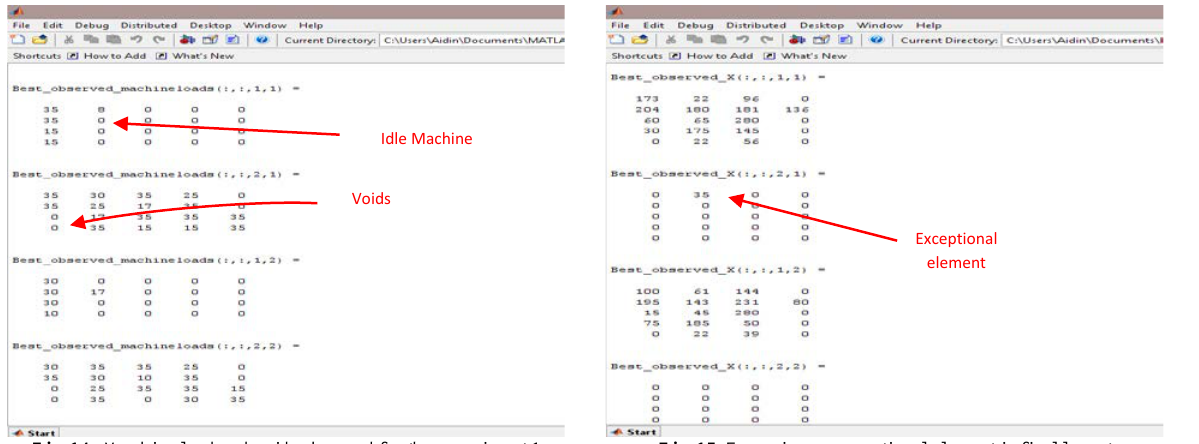
Fig. 14. Machine load and voids observed for the experiment 1 Fig. 15. Emerging an exceptional element in final